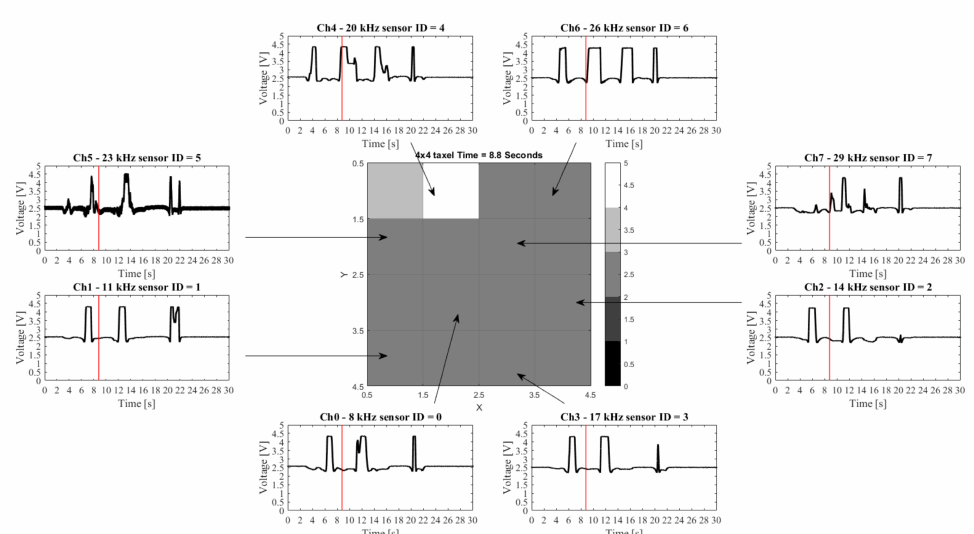
Figure 8. Example of data being transferred and demodulated. The 8 channel signals and corre- sponding associated squares are indicated. The taxel array image is taken at a time of 8.8 s. The line in each plot shows the individual sensor values at that point in time.